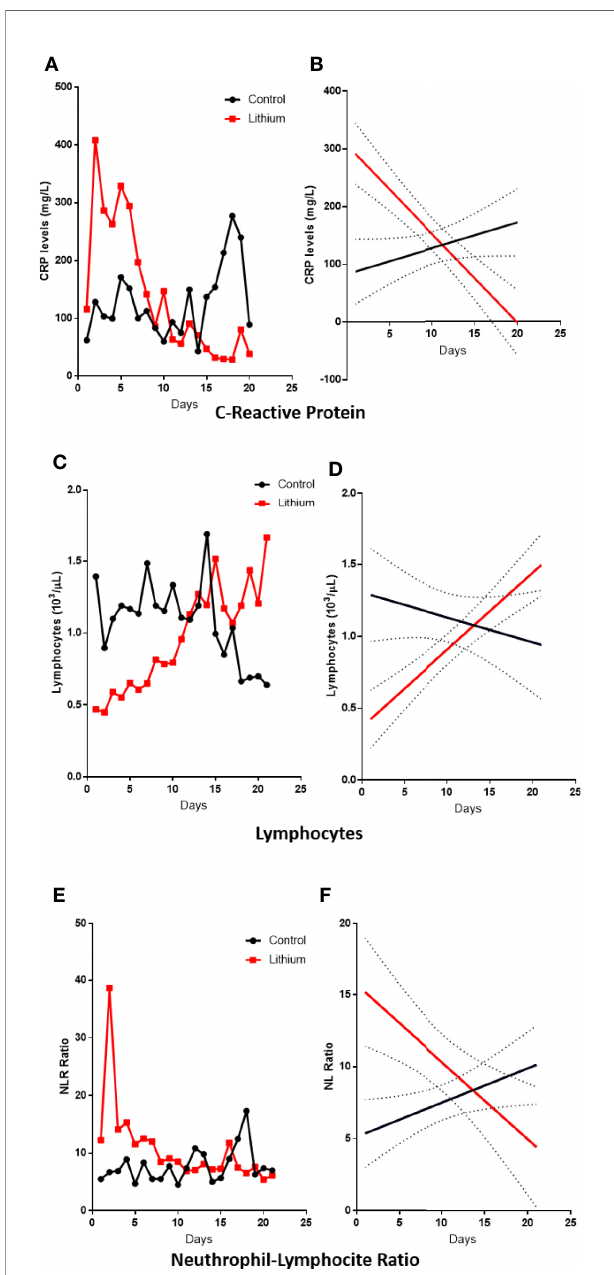
FIGURE 3 | In fl ammatory changes induced by lithium. Left panels represent the average behavior of CRP (A) , lymphocyte (C) and NL-ratio (E) measurements for each day. Results show that patients treated with lithium had a more severe infection than controls, and lithium treatment considerably improved all these parameters. Right panels show linear regression analysis, where a clear different pattern among groups is observed ( p <0.05) with different slopes for CRP (B) , lymphocyte (D) and NL-ratio (F)